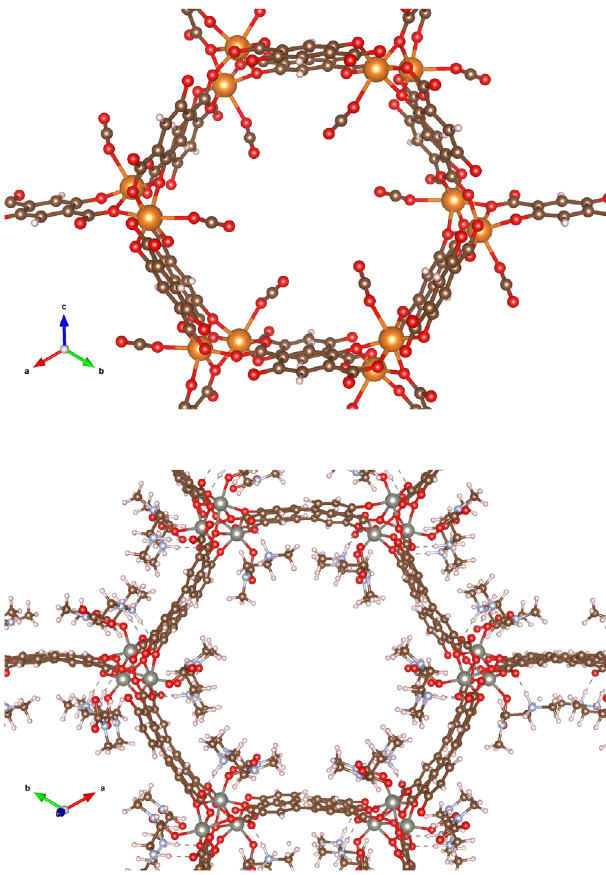
FIG. 10. Optimized crystal structures of CO 2 -adsorbed Mg- MOF-74 (upper panel) and CO 2 -inserted m- 2 -m-Zn 2 ð dobpdc Þ (lower panel). The gray, orange, red, sky blue, brown, and pink circles represent Zn, Mg, O, N, C, and H atoms, respectively. The images are generated using the VESTA program [207].